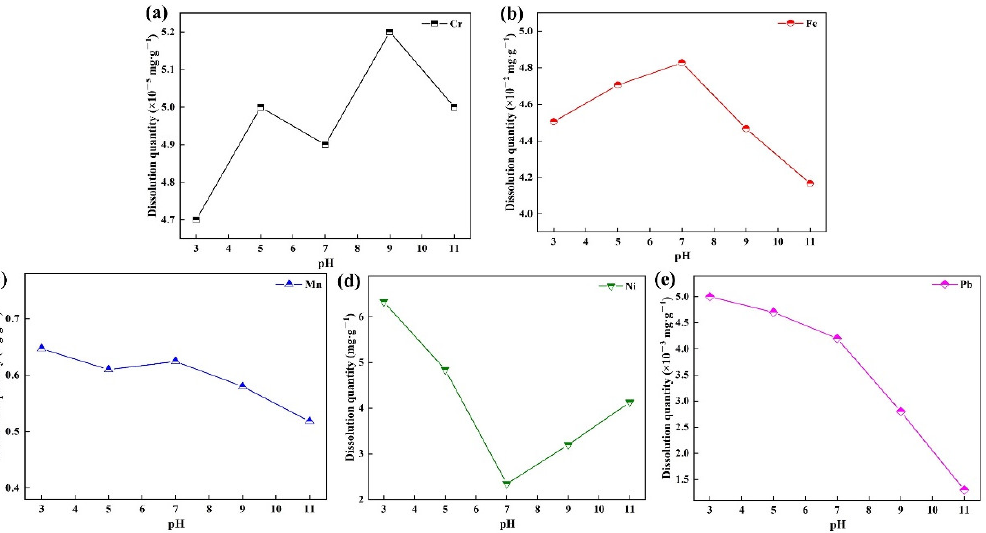
Figure 11. Dissolution effect of metals under different pH conditions . ( a ) is the dissolution curve of Cr; ( b ) is the dissolution curve of Fe; ( c ) is the dissolution curve of Mn; ( d ) is the dissolution curve of Ni; ( e ) is the dissolution curve of Pb.